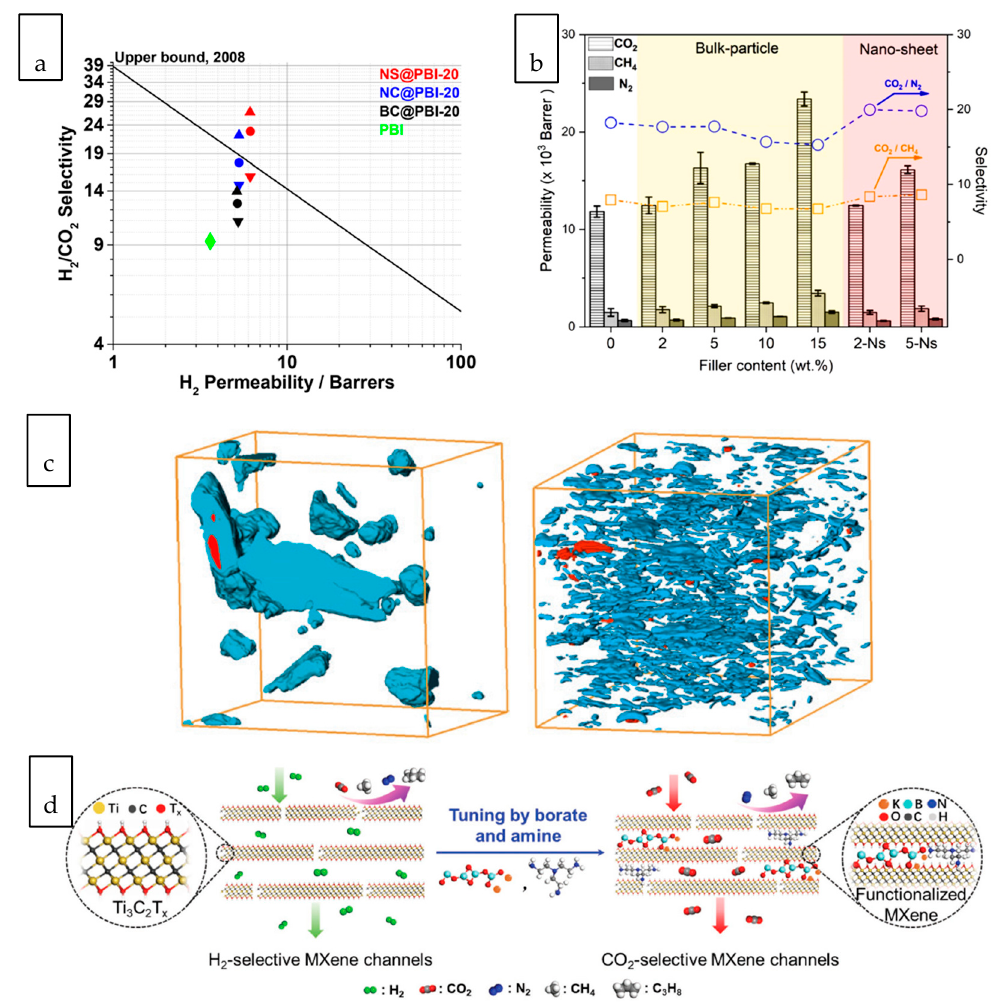
Figure 3. ( a ) H 2 permeabilities versus H 2 / CO 2 selectivities mixed matrix membranes (MMMs) containing 20 wt% of MOFs of different dimensions benchmarked with neat polybenzimidazoles (PBI) membrane (NS: nanosheet; NC: nanocube; BC: bulk crystal) [121], ( b ) CO 2 / CH 4 separation performance of MMM incorporated with MUF-15 crystal bulk and nanosheets [122], ( c ) Segmented (focused ion beam- scanning electrone microscope (FIB–SEM) tomograms of polyimide-based MMM containing bulk-type and nanosheet CuBDC MOF [123], ( d ) Schematic illustration of the interlayer